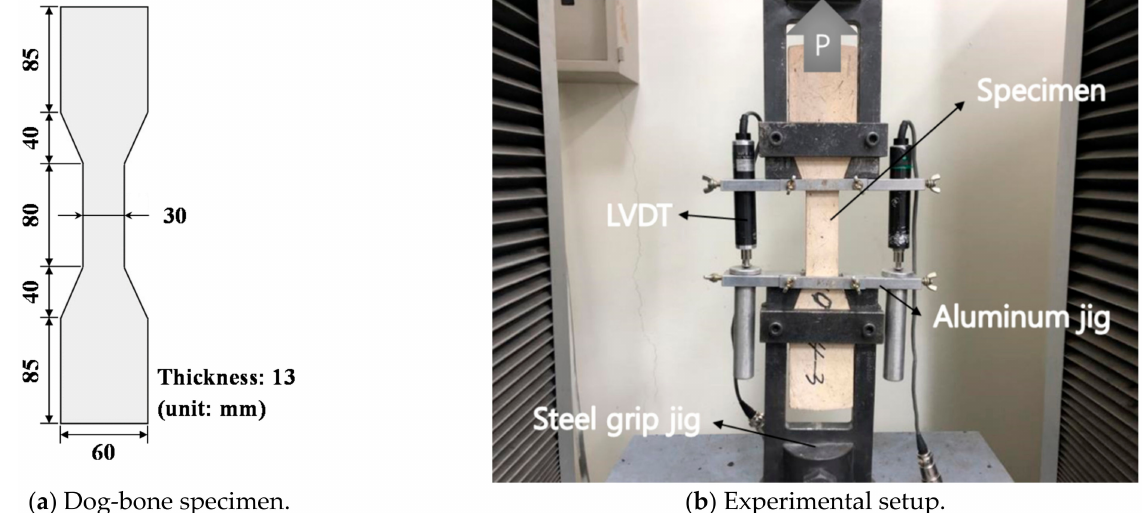
Figure 2. Direct tensile specimen and experimental setup.